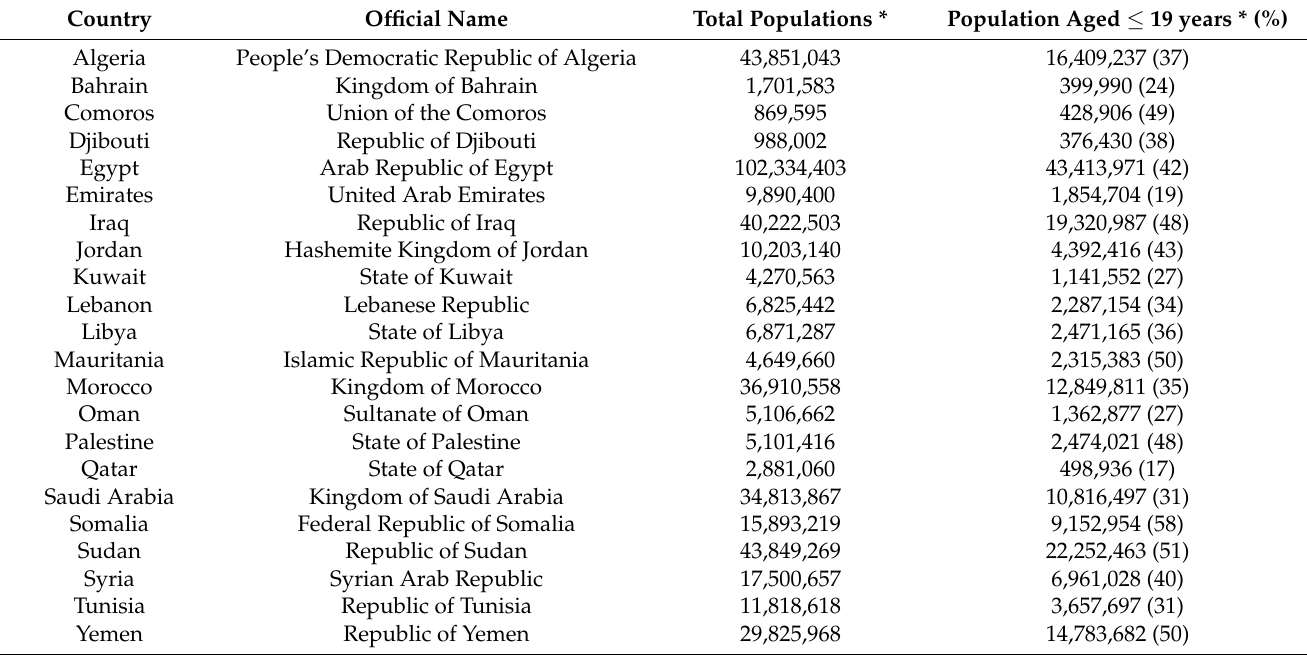
Table 1. The Arabic-speaking countries in alphabetical